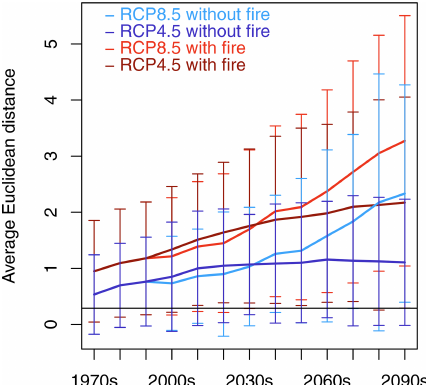
Figure 2. Continental-scale spatial average of Euclidean distance between same-decade partners (SDPs) for the four transient– equilibrium scenario pairings. Error bars represent standard devia- tion of spatial average in a given decade. The horizontal black line at 0.29 indicates the threshold value above which Euclidean distance is assumed to be significantly different from zero.